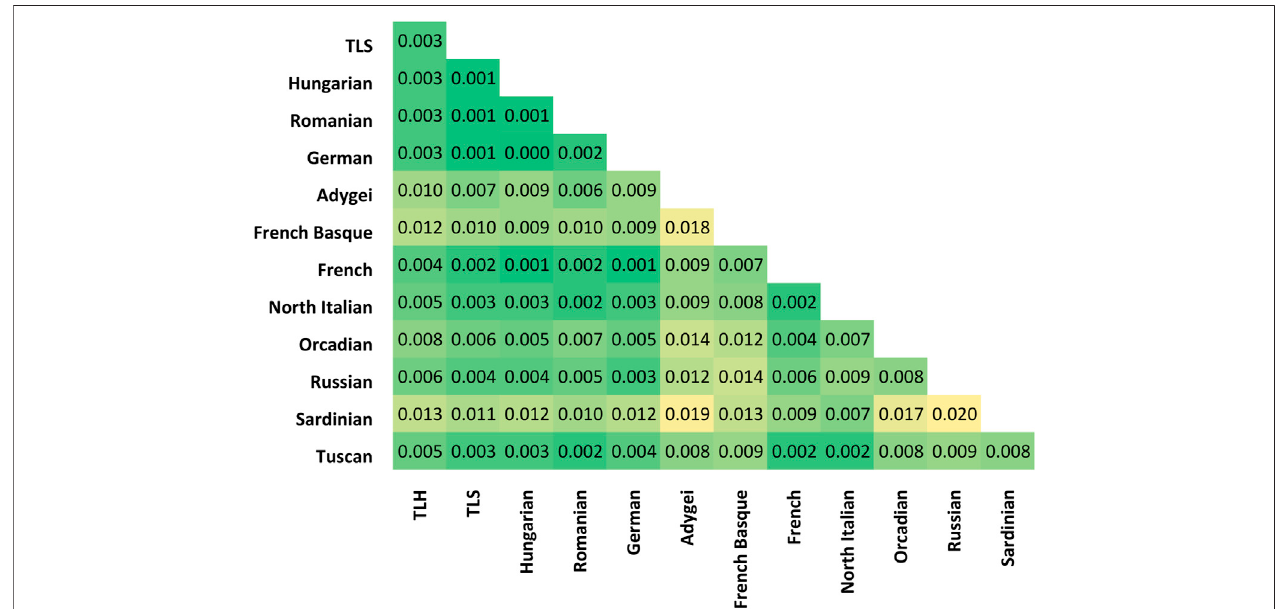
FIGURE 2 | F st calculation